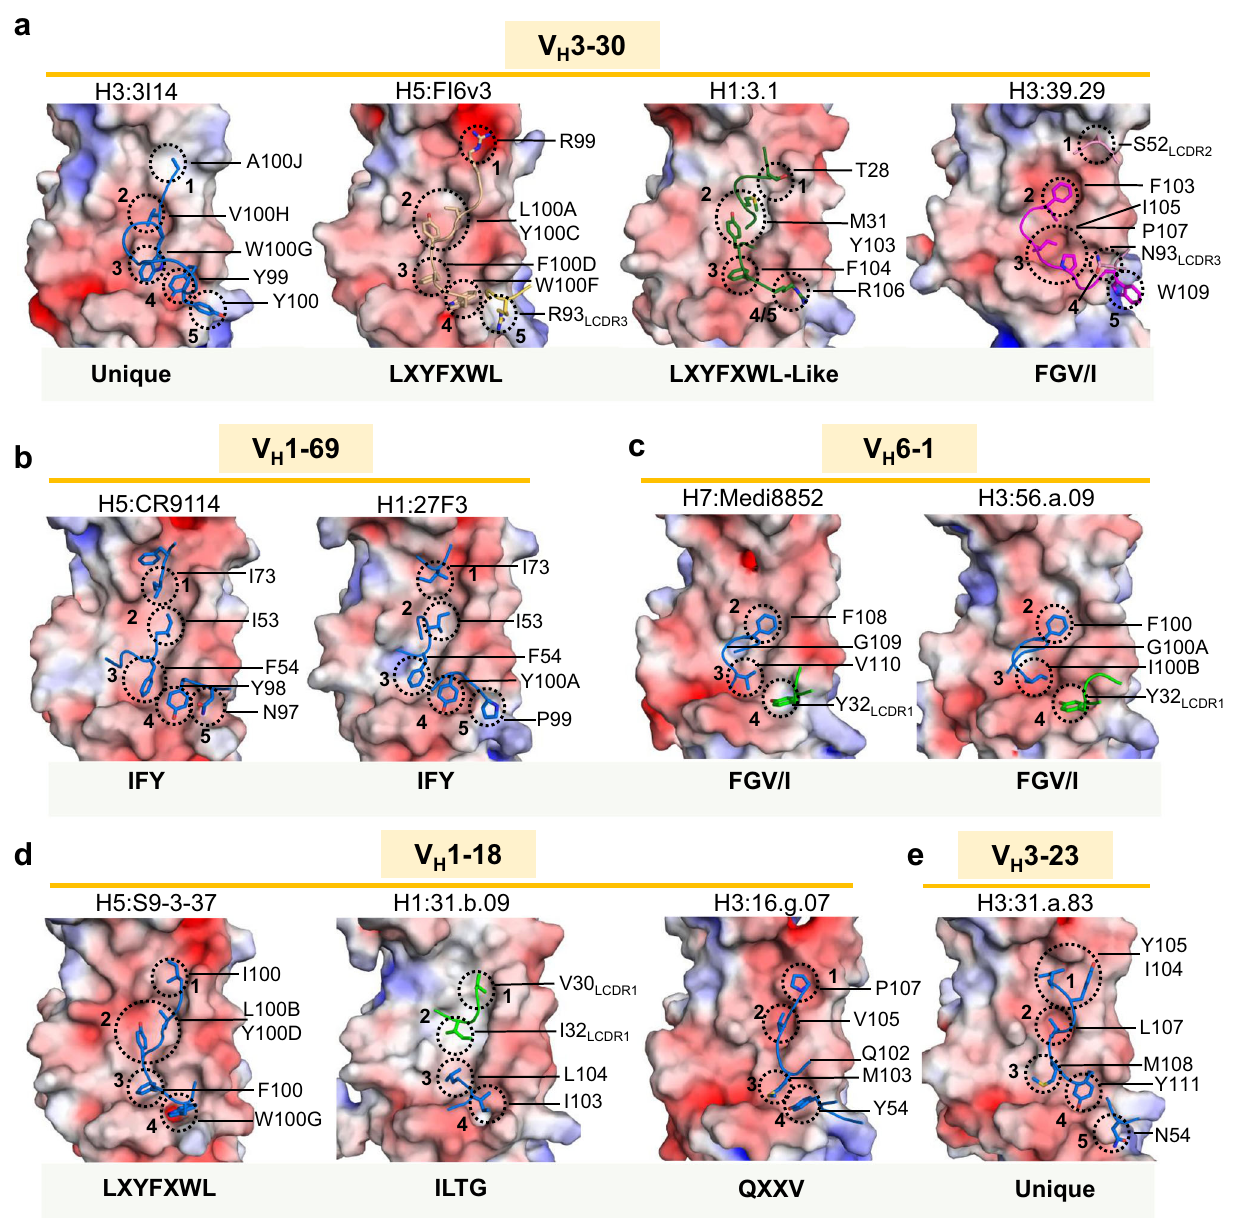
Fig. 7 Comparison of the 3I14 HA stem hydrophobic groove interactions with other stem-bound antibodies. a V H 3-30 interactions with the hydrophobic groove are shown with heavy and light-chain CDRs colored as in Fig. 6. The HA stem is shown in surface representation and colored by electrostatic charge (red-negative, blue-positive, white-neutral). Residues interacting with pockets 1 – 5 are circled with a dotted line and labeled. b Antibodies CR9114 (PDB 4FQI) and 27F3 (PDB 5WKO) from the V H 1-69 germline are shown. c Antibodies Medi8852 (PDB 5JW4) and 56.a.09 (PDB 5K9K) from the V H 6-1 germline. d V H 1-18 antibodies 31.b.09 (PDB 5K9O), S9-3-37 (PDB 6E3H), and 16.g.07 (PDB 5KAN). e The V H 3-3 antibody 31.a.83 (PDB 5KAQ). For b – e , the heavy-chain CDRs are colored blue and the light-chain CDRs are colored green. The molecular signature is indicated below each fi gure or indicated as unique if no signature has been identi fi